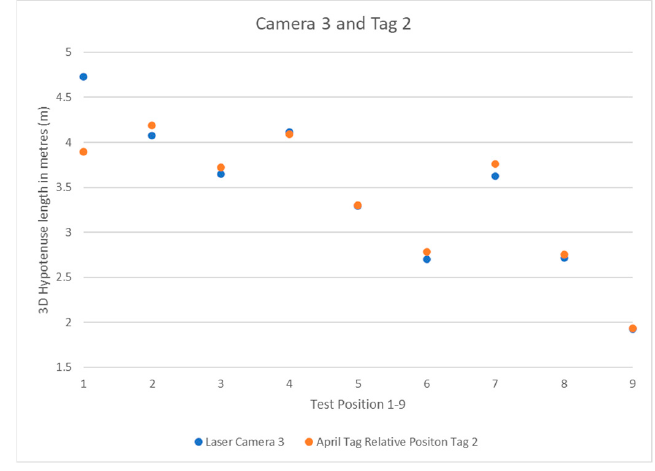
Figure 13. Camera 3 and Tag 1 Position Results.